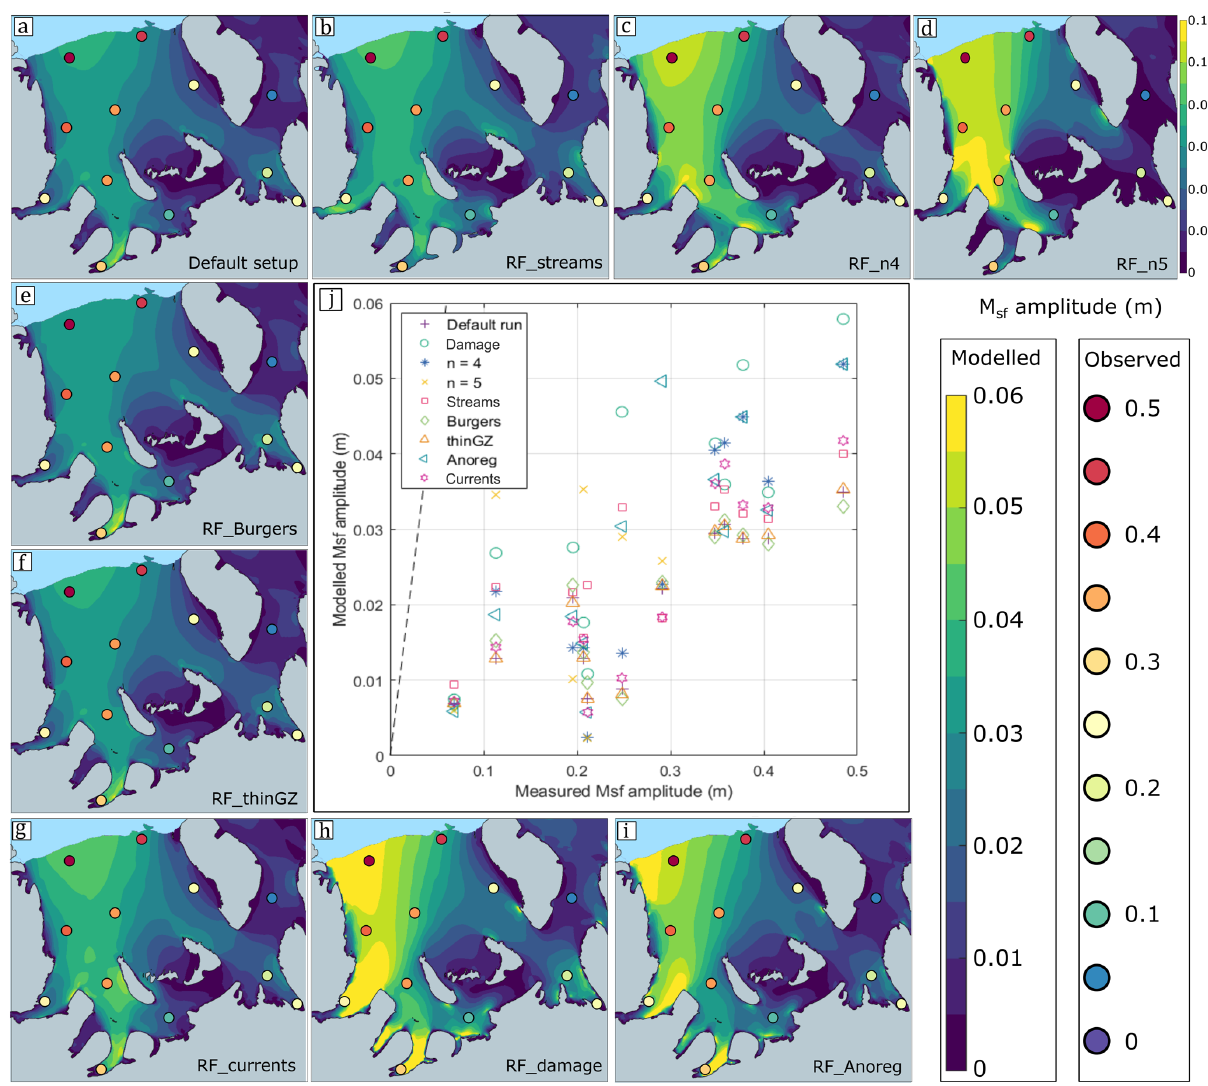
Figure 4. M sf amplitude on the Ronne Ice Shelf for nine of the model experiments (a–i) outlined in Table 1. Note the different colour scale used for experiment “RF_n5” in panel (d) . Observed M sf amplitudes from GPS observations are indicated in panel (a) by coloured circles. Panel (j) compares measured and modelled M sf amplitude at each of the marked locations for the same set of experiments. Note that in producing this figure we use an evenly distributed subset of measurements to avoid bias in areas with more measurements and thus make interpretation of the overall misfit across the entire ice shelf